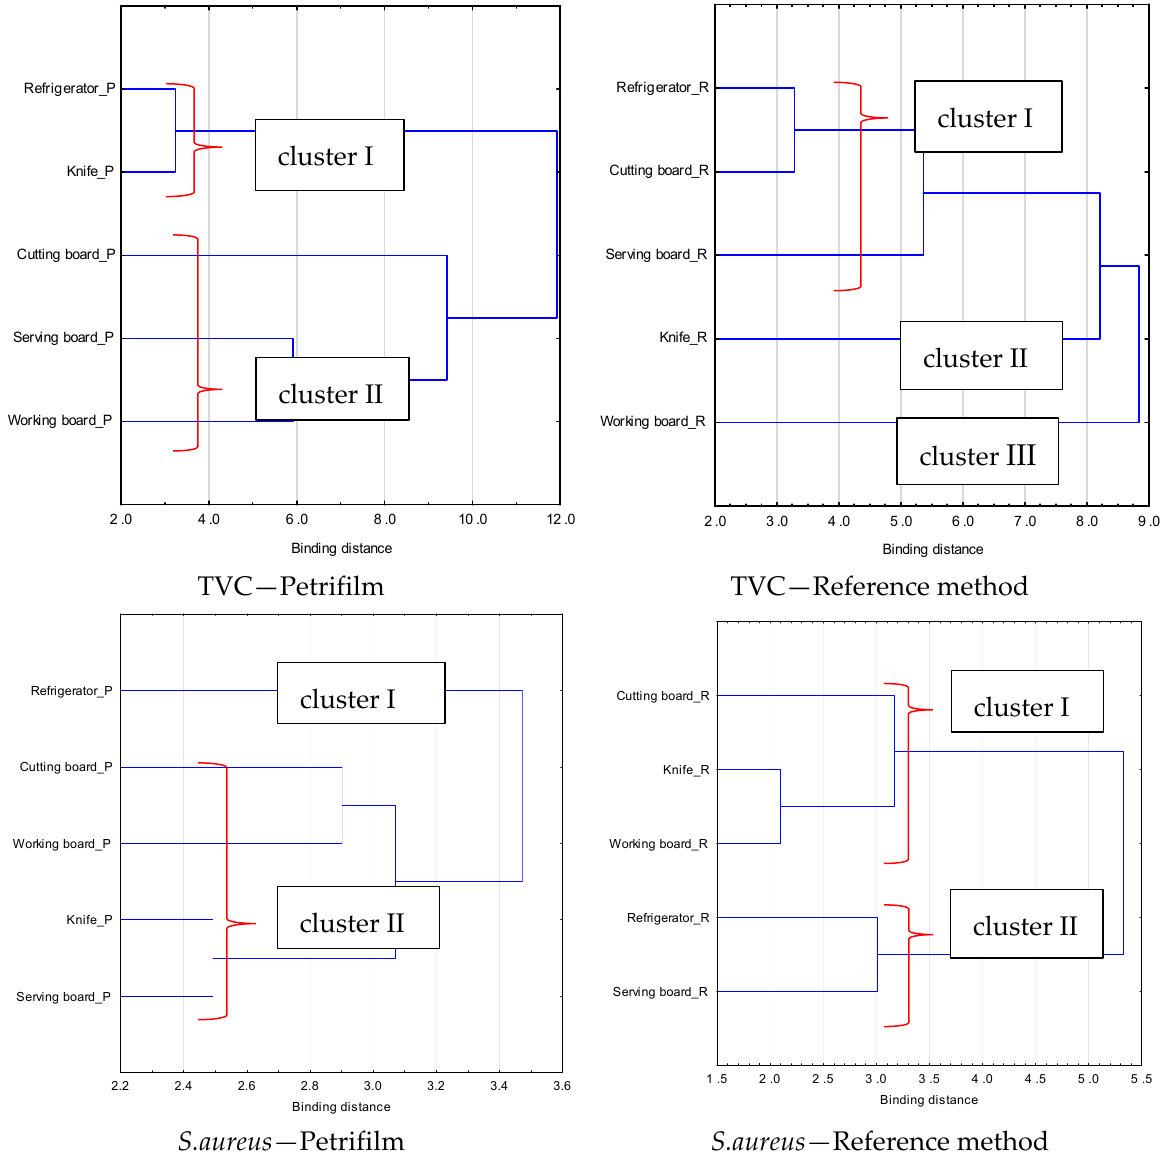
Figure 5. Cluster of surfaces depend on contamination level in analysed food truck outlets.